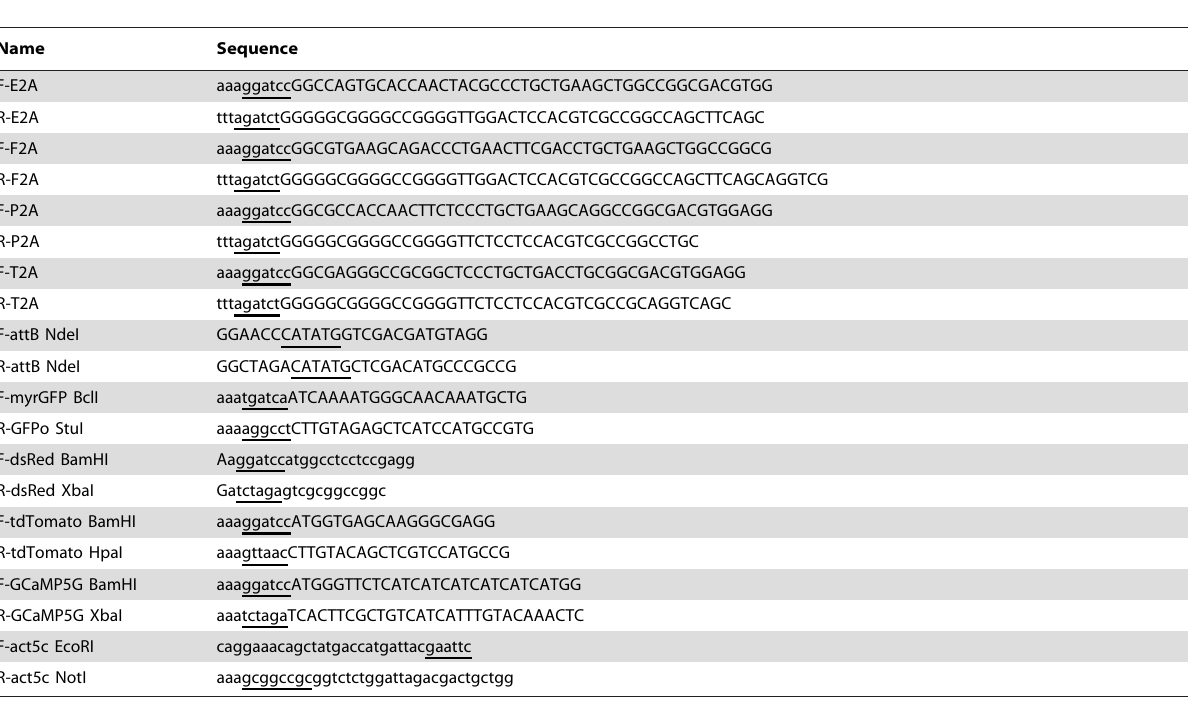
Table 1. Oligonucleotides used in this paper (added restriction enzyme sites